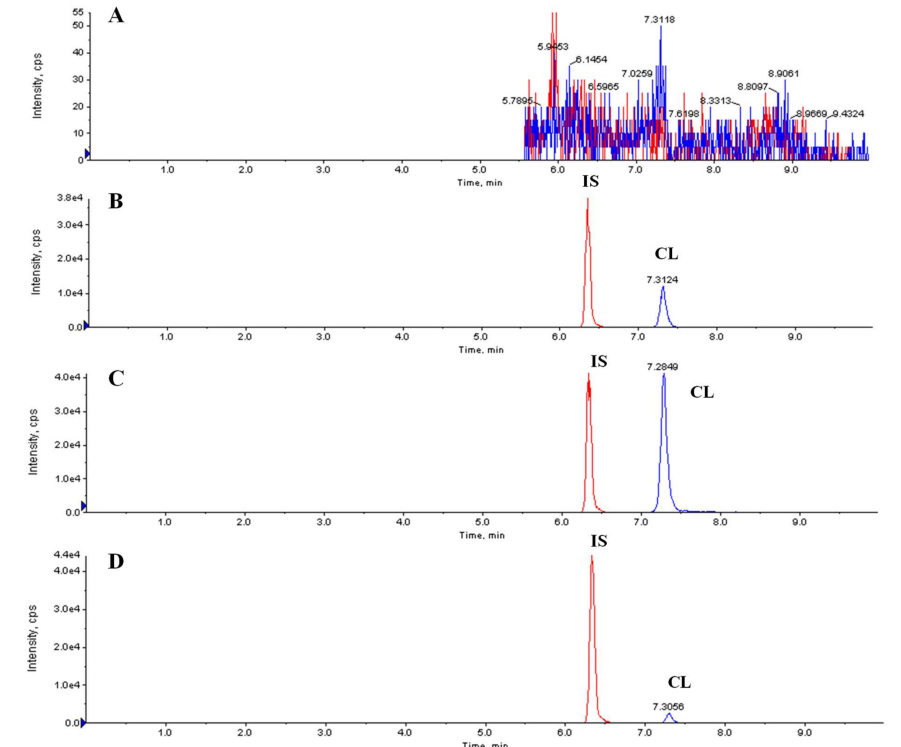
Figure 3. Representative multiple-reaction monitoring (MRM) chromatograms of CL and IS. ( A ) blank plasma; ( B ) blank plasma spiked with CL (100 ng / mL) and IS; ( C ) plasma sample obtained at 0.5 h after intravenous (IV) administration of celastrol-encapsulated silk fibroin nanoparticle (CL-SFNP) suspension; ( D ) plasma sample obtained at 0.5 h after oral (PO) administration of CL-SFNP